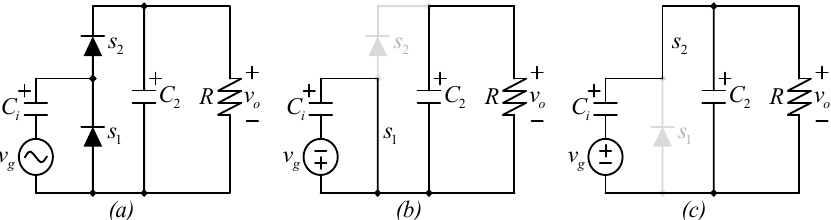
Figure 2. Ac-to-dc switched-capacitor voltage doubler ( a ) topology, ( b ) equivalent circuit when the input voltage is the negative half cycle, ( c ) equivalent circuit when the input voltage is in the positive half cycle.